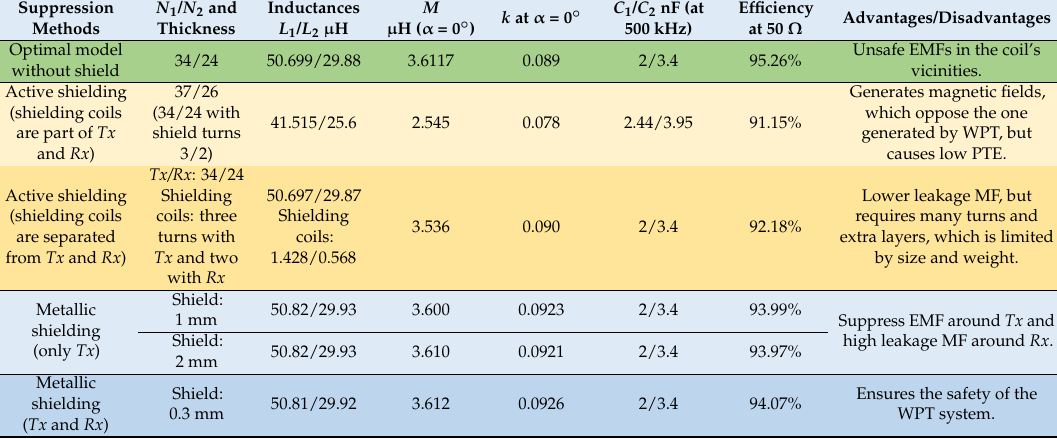
Figure 18. The joint–WPT system with shielding and magnetic field density: ( a ) AL shield for Tx and Rx ; ( b ) 0.1–mm AL shield; ( c ) 0.3–mm AL shield; ( d ) 0.5–mm AL shield. Table 3. A comparative analysis between EMF suppression methods.